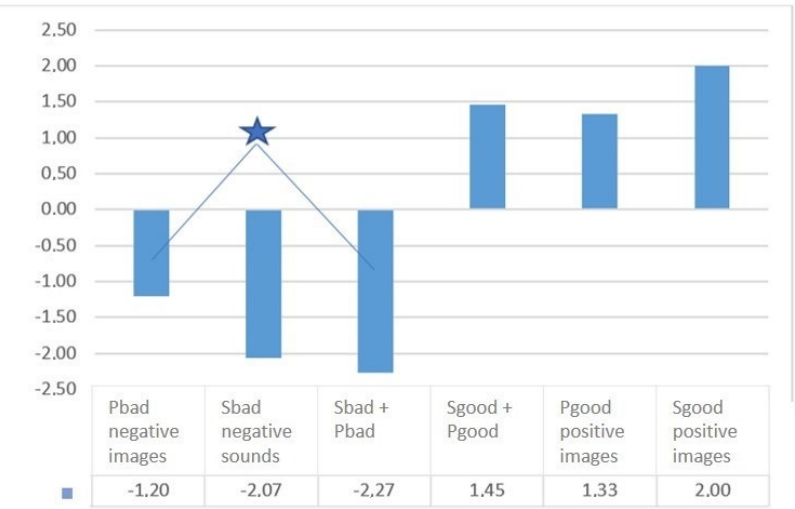
Figure 8. Comparison of the mean valence values of IAPS stimuli for each block-negative video